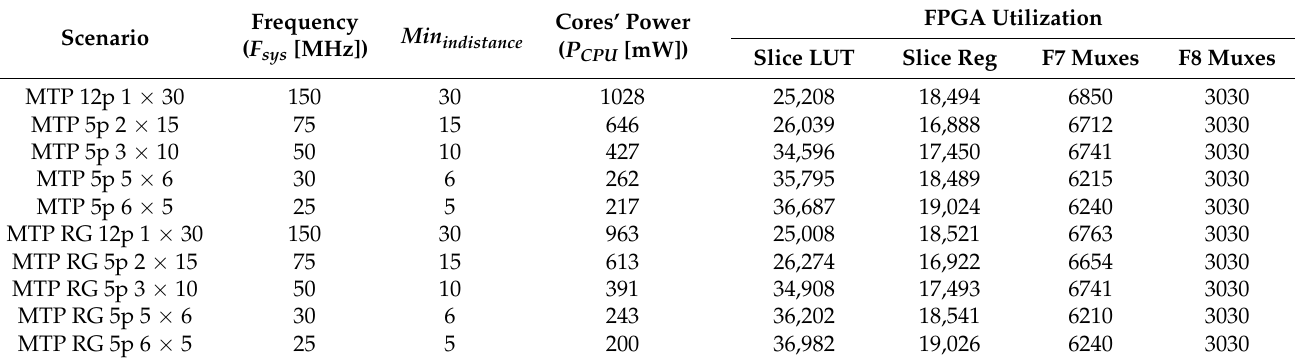
Table 2. Selected results of the experiments with the multitask cores with interleaved pipelines.